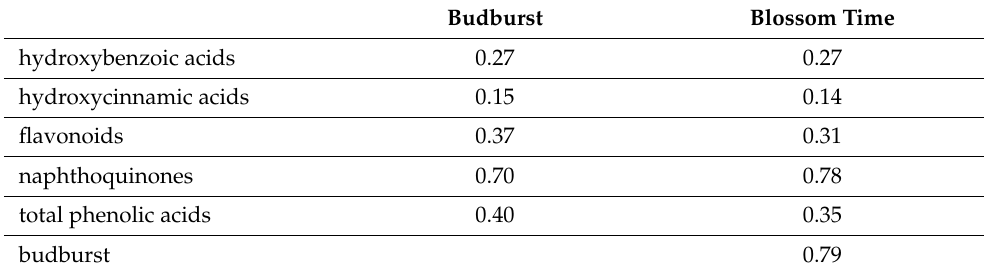
Table 1. Correlation matrix of measured parameters and observed characteristics (R 2 ) *. Budburst